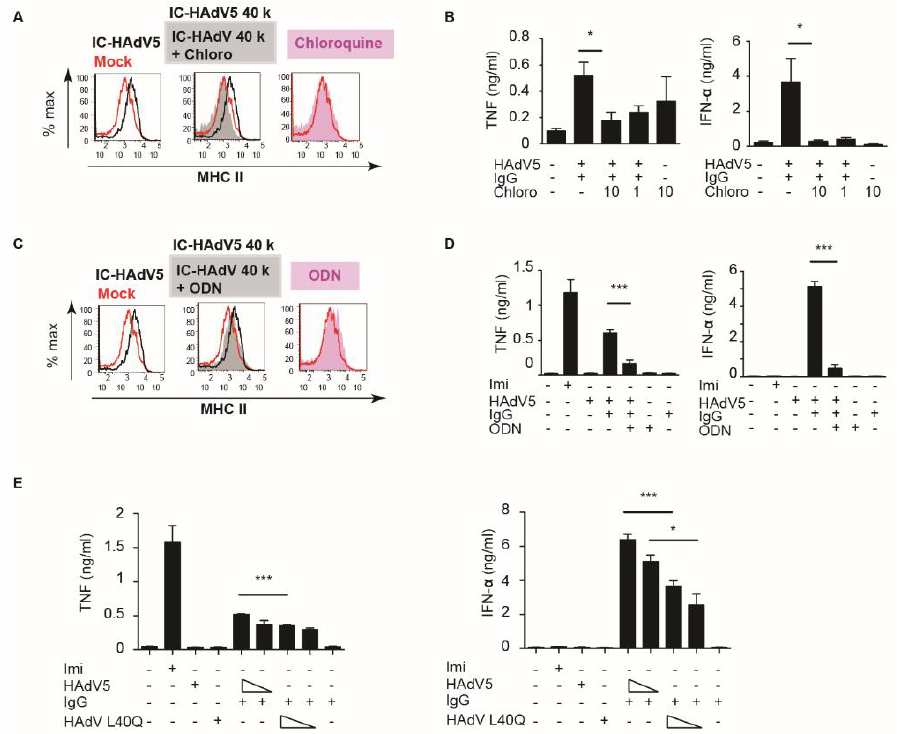
Figure 3. pDCs deliver IC-HAdV5 to endosomal vesicles. ( A ) pDCs were pre-treating with chloro- quine (10 or 1 nM) for 2 h, then challenged with IgG, HAdV5, or IC-HAdV5. MHC II cell surface levels were quantified by flow cytometry ( n = 3, with similar results between donors). ( B ) pDCs were pre-treating with chloroquine for 2 h, then challenged with IgG, HAdV5, or IC-HAdV5. TNF and IFN- α levels in the supernatant were quantified by ELISA ( n = 3, p values were derived from t -test, * corresponds to p < 0.01). ( C ) pDC activation was assessed by pre-treating cells with 50 nM of ODN 2216 for 2 h, then stimulated with IgG, HAdV5, or IC-HAdV5. MHC II cell surface levels were quantified by flow cytometry ( n = 3, with similar results between donors). ( D ) pDC activation was assessed by pre-treating cells with 50 nM of ODN 2216 for 2 h then stimulated with IgG, HAdV5, or IC-HAdV5. TNF and IFN-α levels in the supernatant were quantified by ELISA ( n = 3, p values were derived from t -test, *** corresponds to p < 0.0001). ( E ) pDCs were challenged with IgG, HAdV5, HAdV L40Q, or IC-HAdV5; IC-HAdV L40Q in dose dependent and pDCs in each condition were collected, and detected IFN α and TNF secretion. Experiments were carried out in three independent experiments. p values were derived from t -tests. * and *** correspond to p < 0.01 and p < 0.0001, respectively.